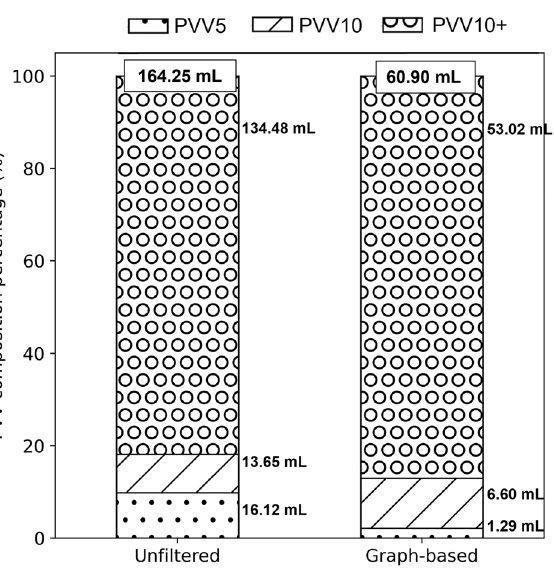
Figure 2. The impact of filtering segmentation artefacts on the estimation of pulmonary vessel-like (PVV) subvolumes for IPF. The bars indicate the percentage of PVV that is PVV10 + (dotted hatch), PVV10 (slashed hatch), and PVV5 (grey hatch). Numerical labels indicate the absolute values (mL) of each volume compartment. PVV5: volume of vessels with cross-sectional area less than 5 mm 2 ; PVV10: volume of vessels with cross-sectional area 5–10 mm 2 ; PVV10 + : volume of vessels with cross-sectional area > 10 mm 2